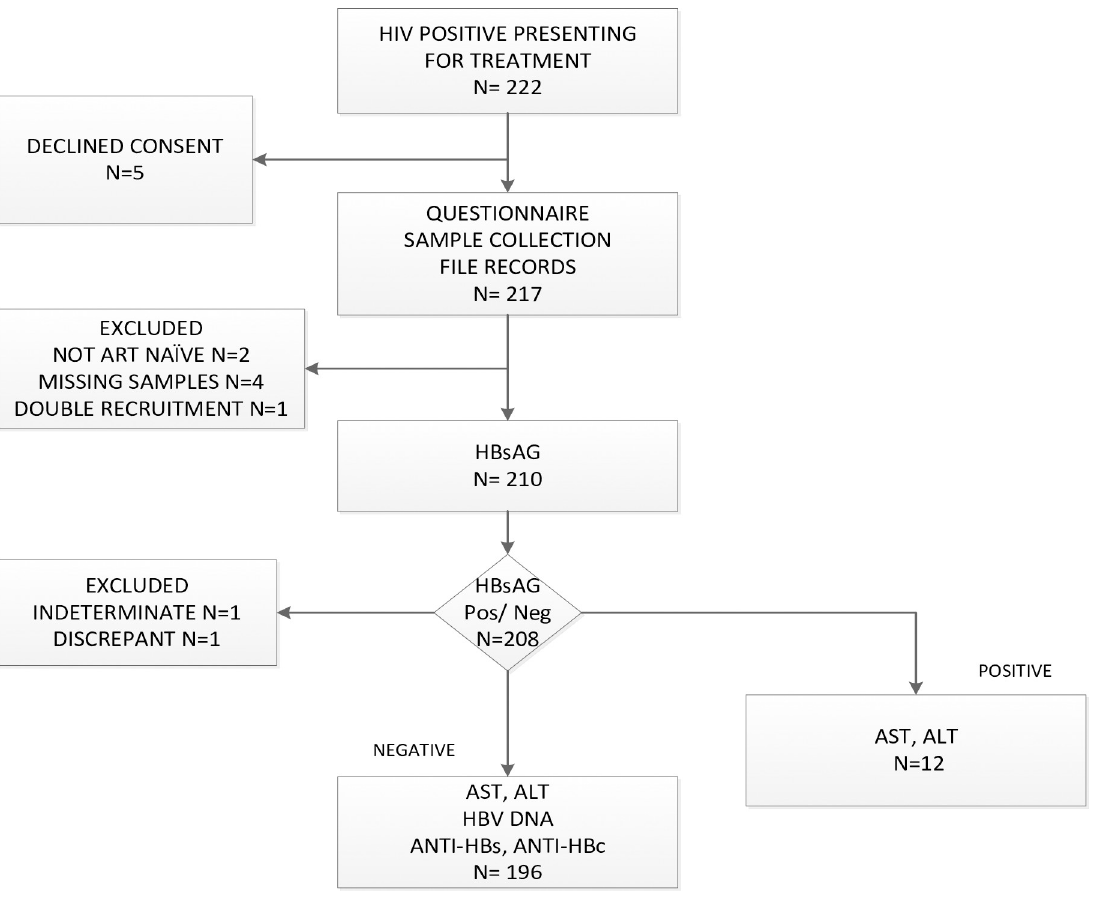
Fig 1. Study Flow of recruitment and